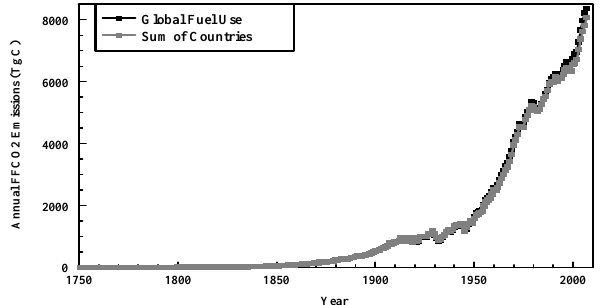
Fig. 1b. Comparison of FFCO2 emissions from global fuel use and the sum of countries for the years 1751 to 2007. This figure was created from the sum of national production and consumption values for 15,830 country-year pairs. Data from Boden et al. (2010).